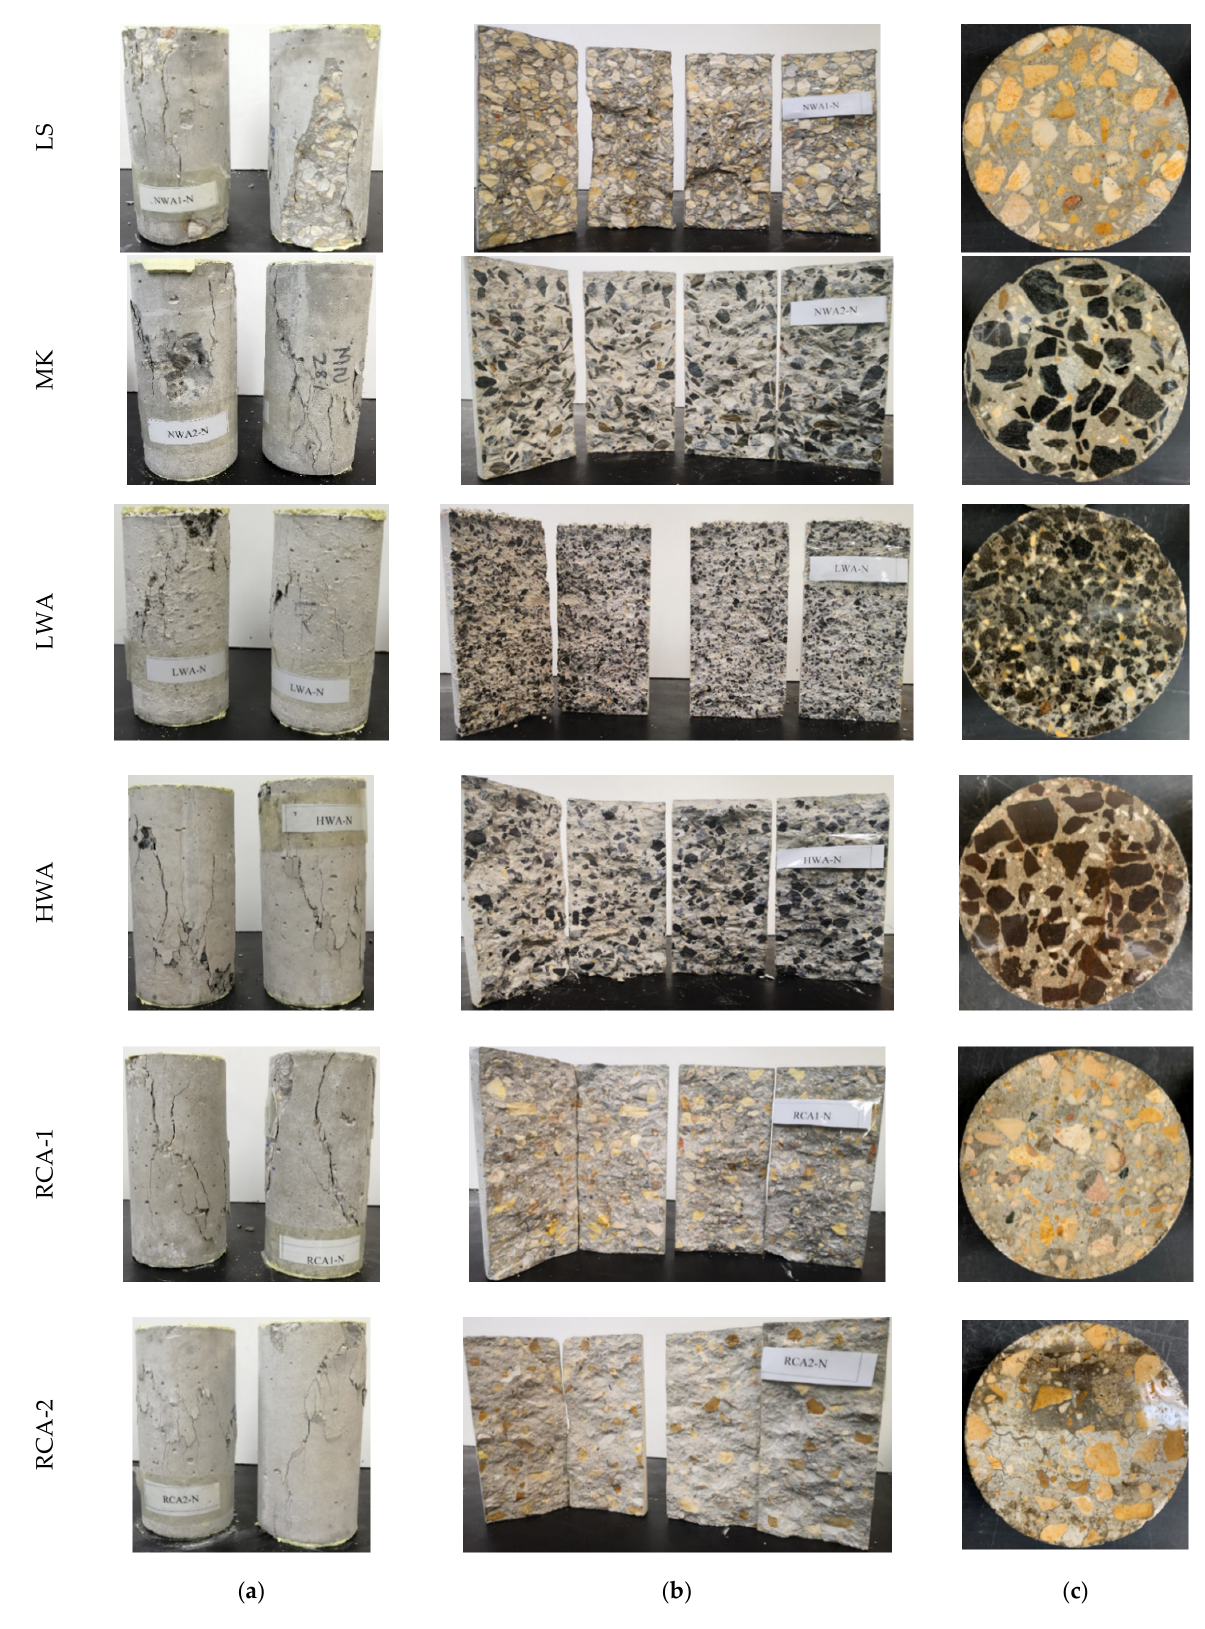
Figure 4. Illustrative photographs of Mix 2: ( a , b ) compression and splitting tension failure; and ( c ) cross